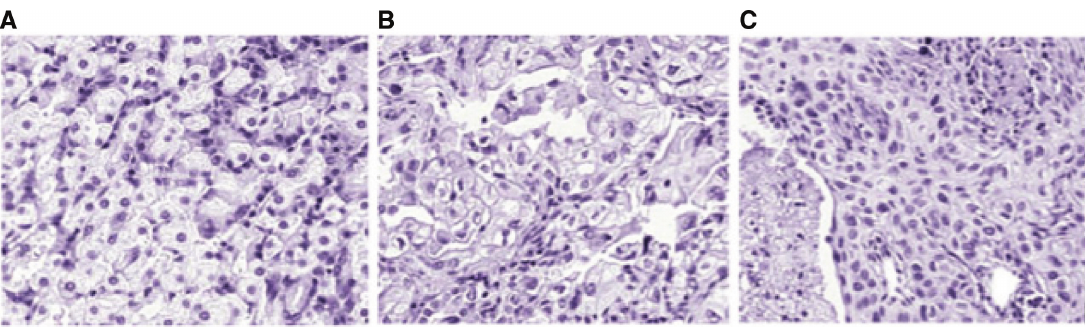
Figure 4: Preprocessed image. (A) Normalized normal image, (B) normalized adenocarcinoma image, (C) normalized squamous